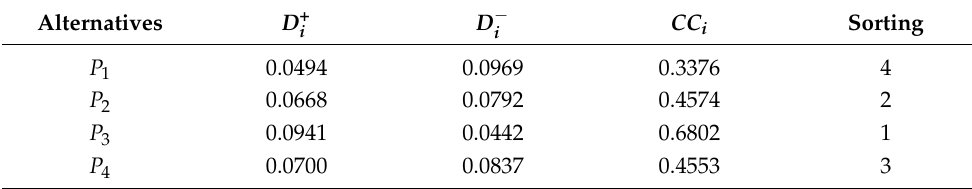
Table 7. The closeness coefficients and the priority of